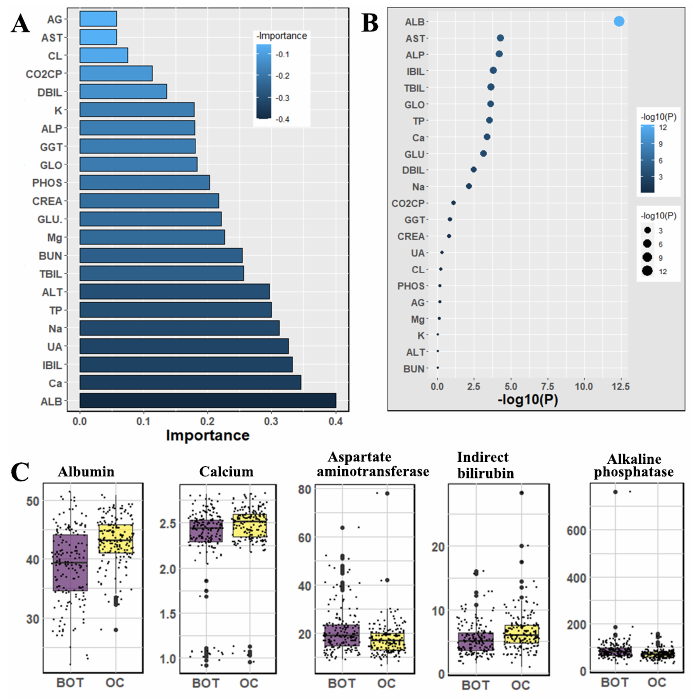
Figure 3. The analysis results for the dataset general chemistry tests; ( A ) The feature importance of general chemistry tests calculated by ML algorithms according to coefficient values after model training; ( B ) The association between benign ovarian tumor and ovarian cancer patients applying independent sample t -test, the lighter and larger bubble represent higher association; ( C ) The box plot of the five top most associated general chemistry